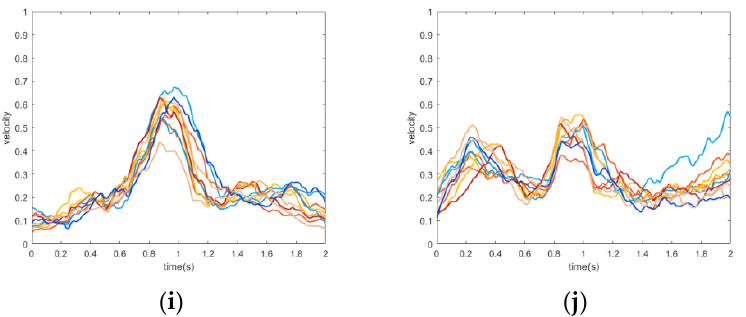
Figure 7. The integrated velocity tendency of air writing digits where each color line denotes each sample: ( a ) 0; ( b ) 1; ( c ) 2; ( d ) 3; ( e ) 4; ( f ) 5; ( g ) 6; ( h ) 7; ( i ) 8; ( j ) 9.